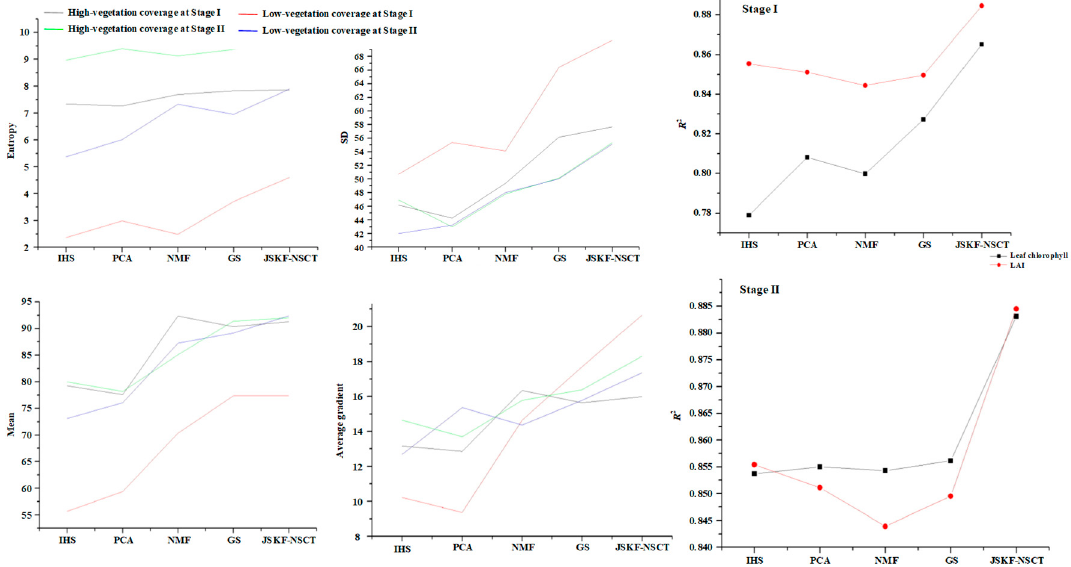
Figure 11. Comparison of the fusion results among our proposed algorithm and other fusion methods.